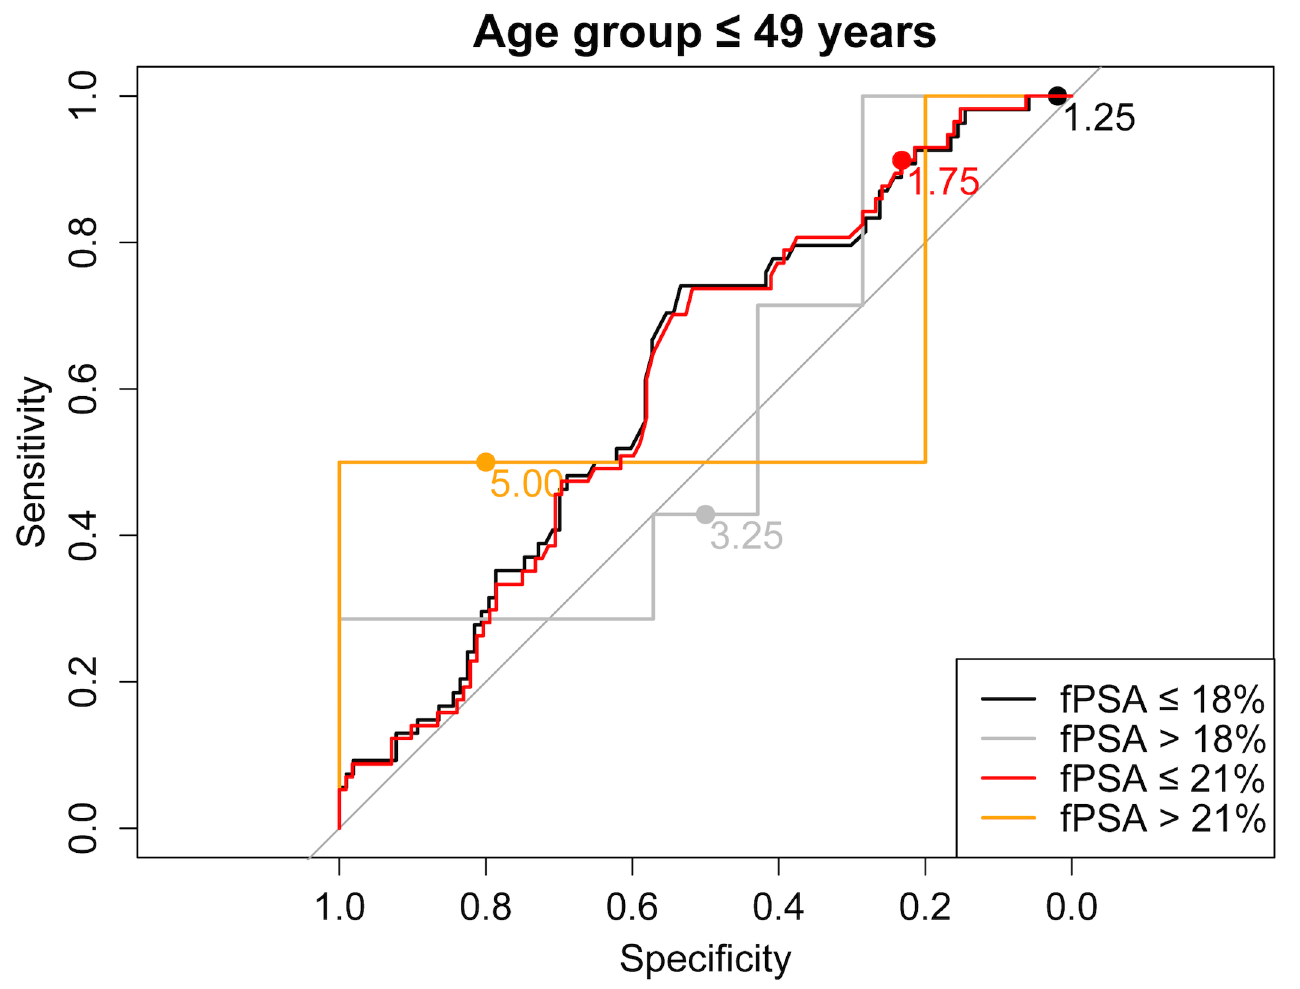
Fig 1. ROC curve for the age group (cid:1) 49 years stratified for fPSA values (cid:1) 18% vs. > 18% and (cid:1) 21% vs. > 21%, respectively.